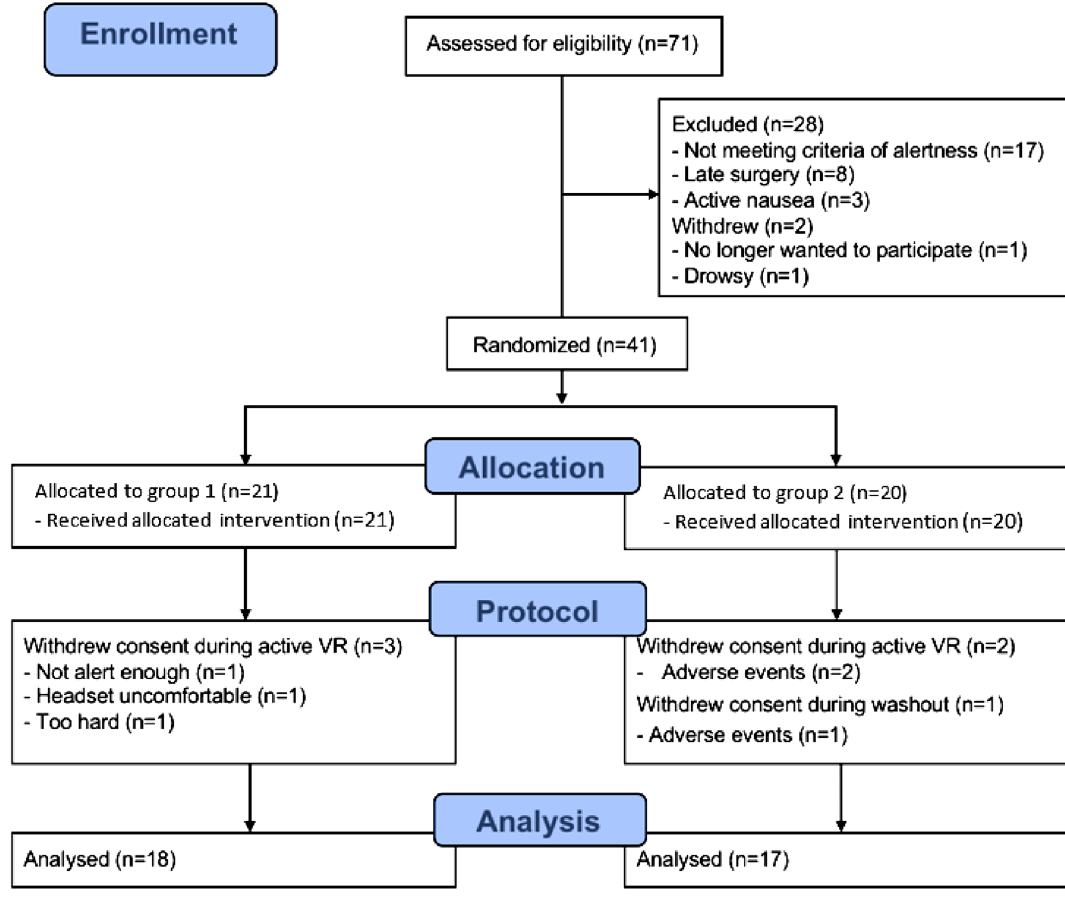
Parameters Results for Group 1 (n = 18) Results for Group 2 (n = 17)